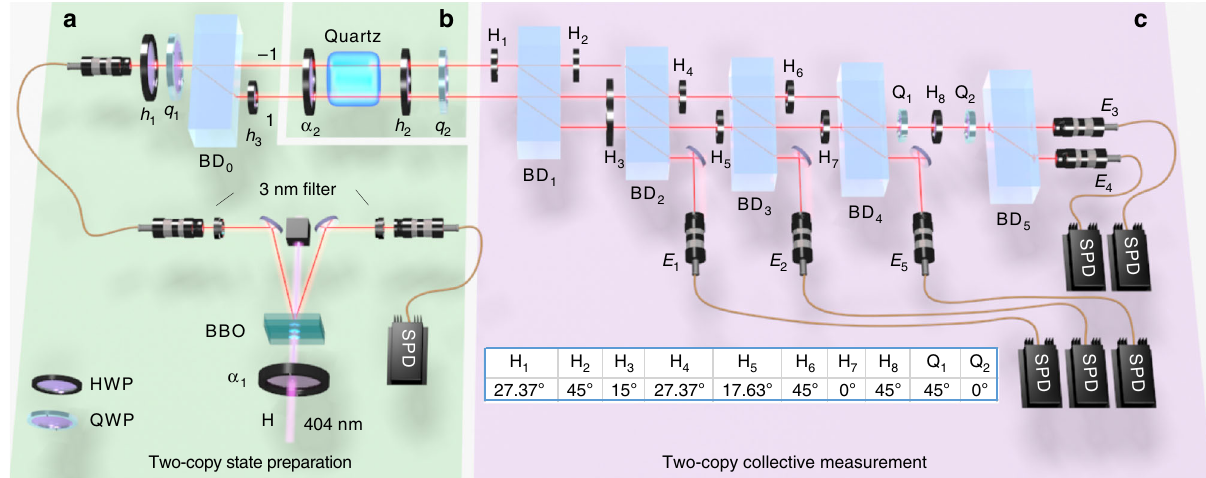
Fig. 2 Experimental setup for realizing the collective SIC-POVM. The setup consists of two modules designed for two-copy state preparation ( a , b ) and two-copy collective measurement c , respectively. In the two-copy state-preparation module, a prepares the fi rst copy (walker qubit) in the path degree of freedom; b prepares the second copy (coin qubit) in the polarization degree of freedom. The two-copy collective measurement module ( c ) performs the collective SIC-POVM via photonic quantum walks as illustrated in Fig. 1d. Here beam displacers (BDs) are used to realize the conditional translation operator T . Combinations of half wave plates (HWPs) and quarter wave plates (QWPs) with rotation angles speci fi ed in the embedded table are used to realize site-dependent coin operators C ( x , t ). Five single-photon detectors (SPDs) E 1 to E 5 correspond to the fi ve outcomes of the collective